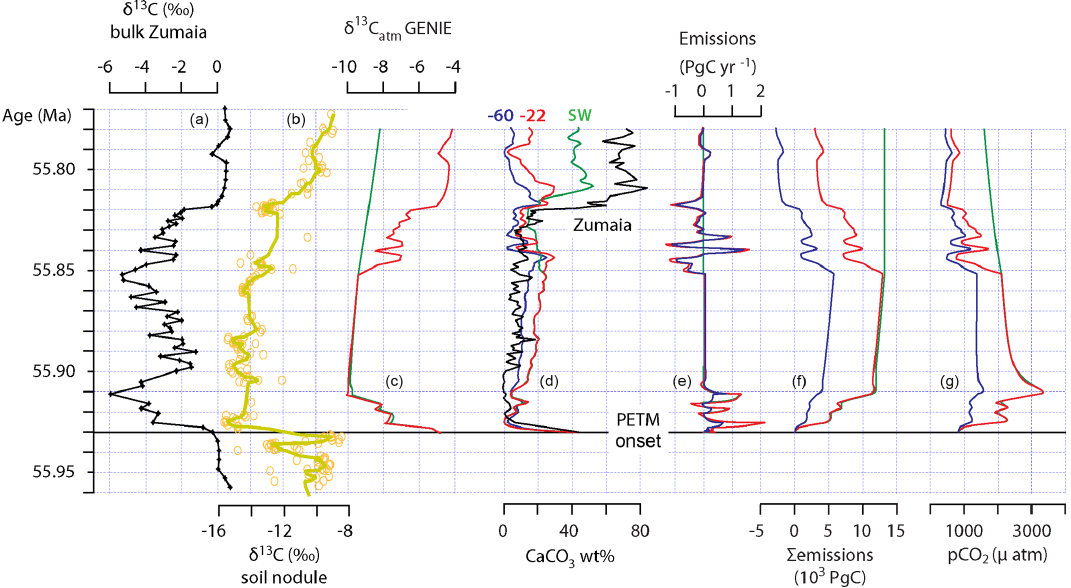
Figure 7. Results of inverse modelling with the cGENIE Earth system model: (a) the bulk carbonate δ 13 C for Zumaia which drives model inversions; (b) soil nodule δ 13 C record of the Big Horn Basin, as representative of atmospheric CO 2 δ 13 C for comparison to model results; (c) modelled δ 13 C composition of atmospheric carbon dioxide; (d) modelled and actual weight percentage of CaCO 3 content of the sediment column at Zumaia; (e) carbon emission rate in petagrams of carbon per year; (f) cumulative carbon emissions (cumulative input minus removal); (g) modelled atmospheric p CO 2 . The model scenarios are as follows: (1) carbon input at δ 13 C of − 22‰ during the onset, no carbon removal (green); (2) carbon input and removal with δ 13 C of − 22‰ to follow Zumaia target CIE (red); (3) carbon input with δ 13 C of − 60‰ and removal of carbon with δ 13 C of − 22‰ to follow Zumaia target CIE (blue). All simulations have active temperature-dependent silicate weathering feedbacks operative